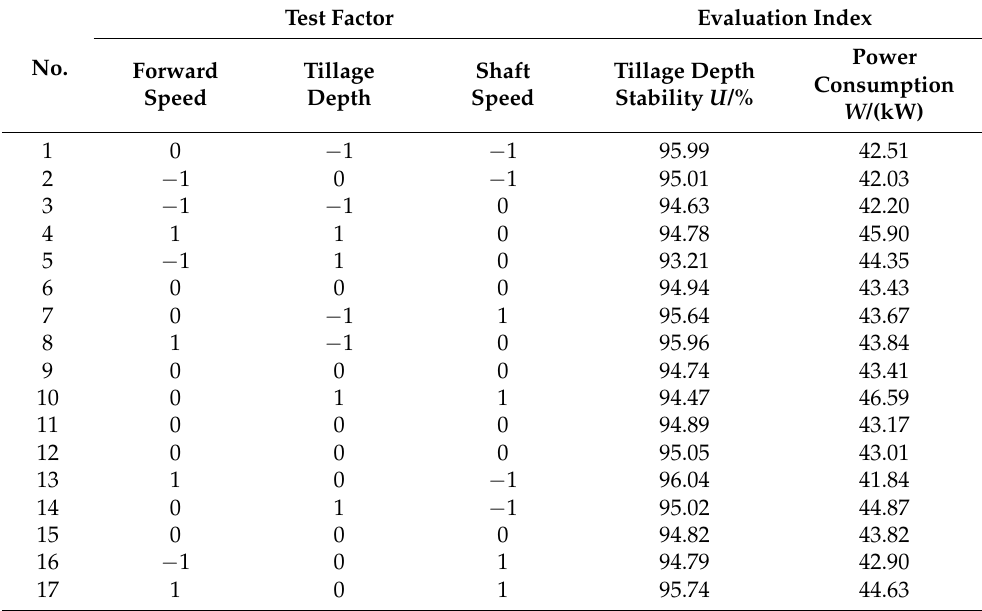
Table 6. Experimental protocol and results.